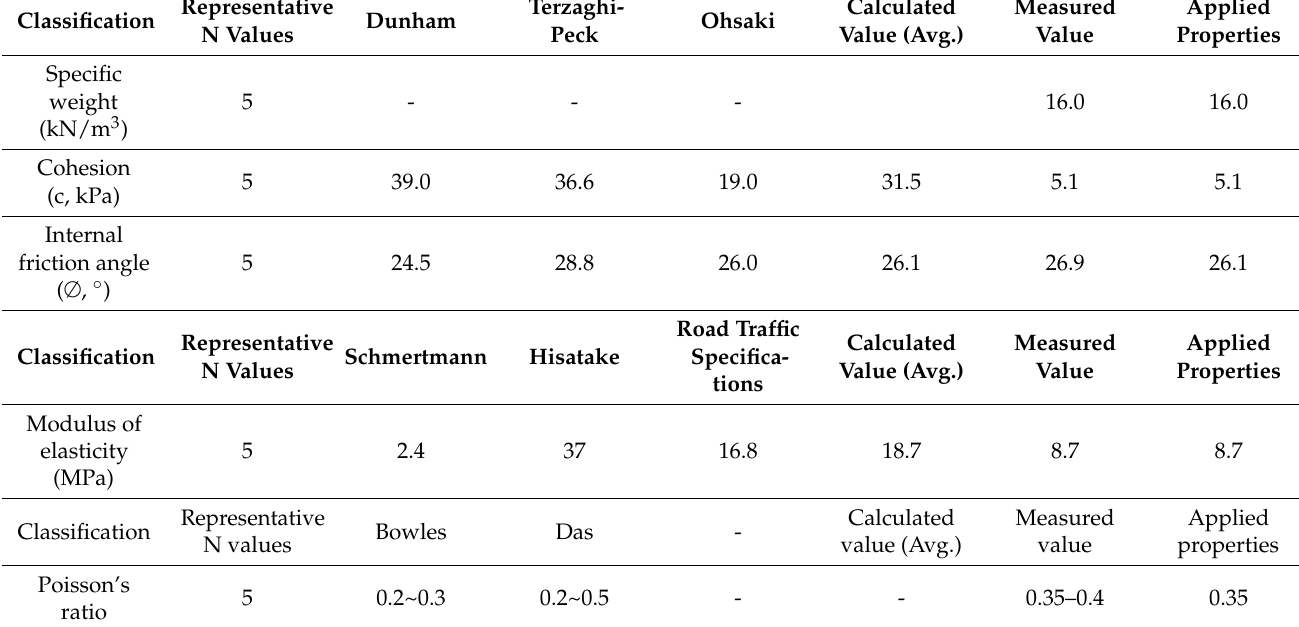
Table 3. Estimated values of physical properties of the ground.